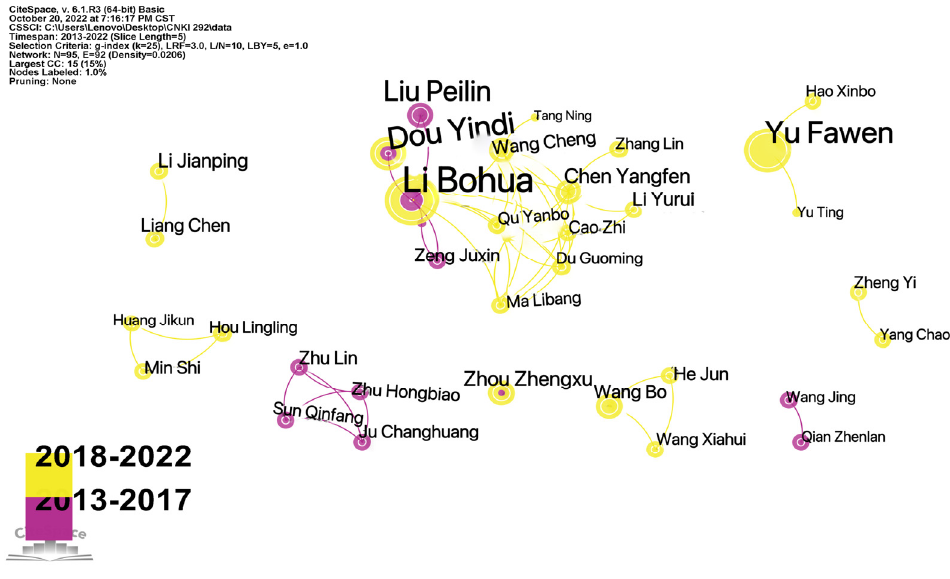
Figure 5. Knowledge map of the author cooperation network for rural human settlements research from 2013 to